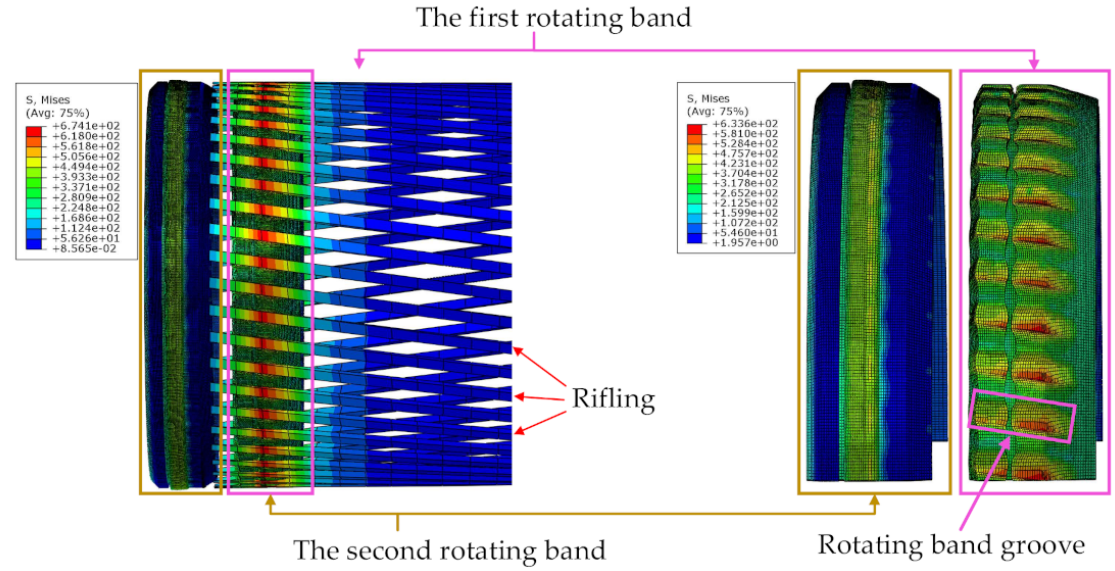
Figure 13. Appearance and stress distribution of the rotating bands and riflings in the first period.